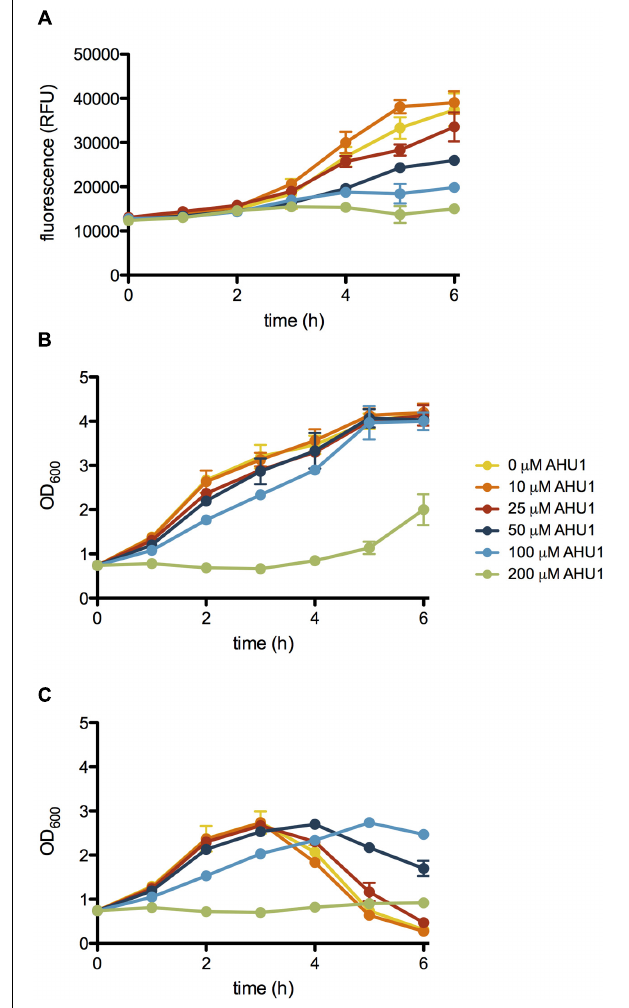
FIGURE 3 | Effect of AHU1 on stx2 ::GFP expression, growth rate and lysis of E. coli . ZAP0273 transformed with pNY16 was cultured in the presence of 25 − 200 µ M AHU1, and induced with 1 µ g/ml MMC. Expression of stx2 ::GFP expression was measured by fluorescence, and bacterial growth by OD 600 . (A) Inhibition of MMC-induced stx2 ::GFP expression by AHU1. (B) Effect of AHU1 on bacterial growth in the absence of MMC. (C) Inhibition of MMC-induced bacterial lysis by AHU1. Experiments were performed in triplicate, and data plotted as the mean with standard deviation from the mean displayed by error bars.